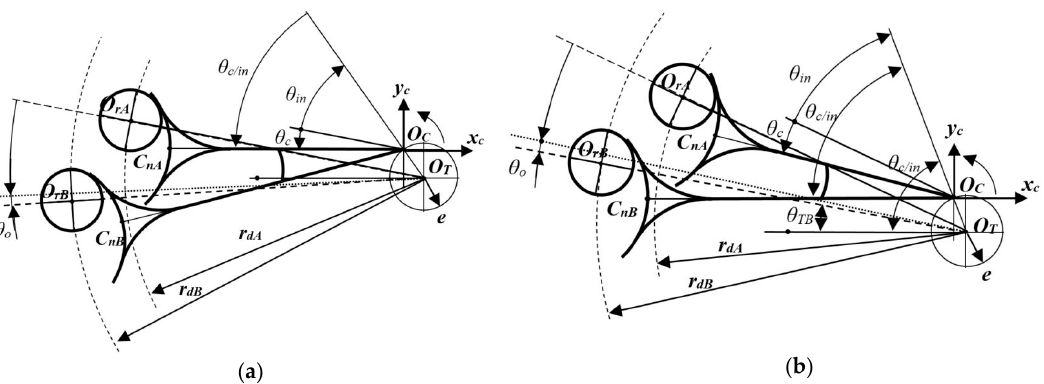
Figure 3. Schematics of the conjugate lobe cam for synthesis: ( a ) the input lobe cam; ( b ) the output lobe cam.